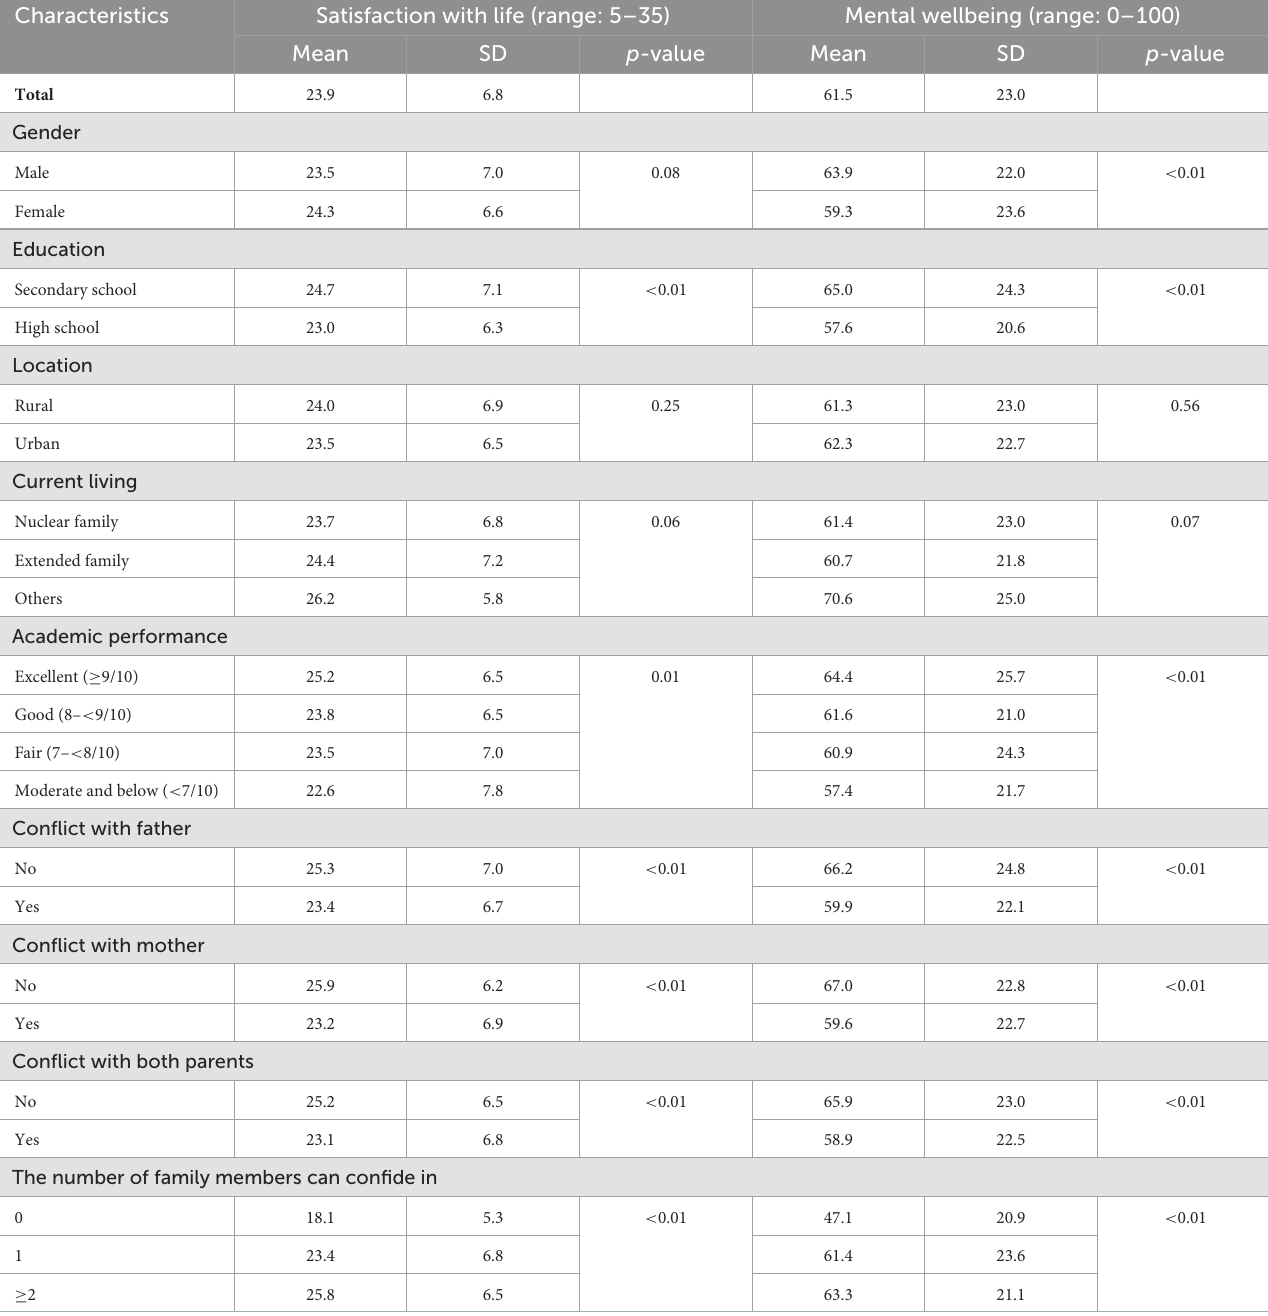
TABLE 3 The SWLS and WHO-5 of participants regarding different characteristics.